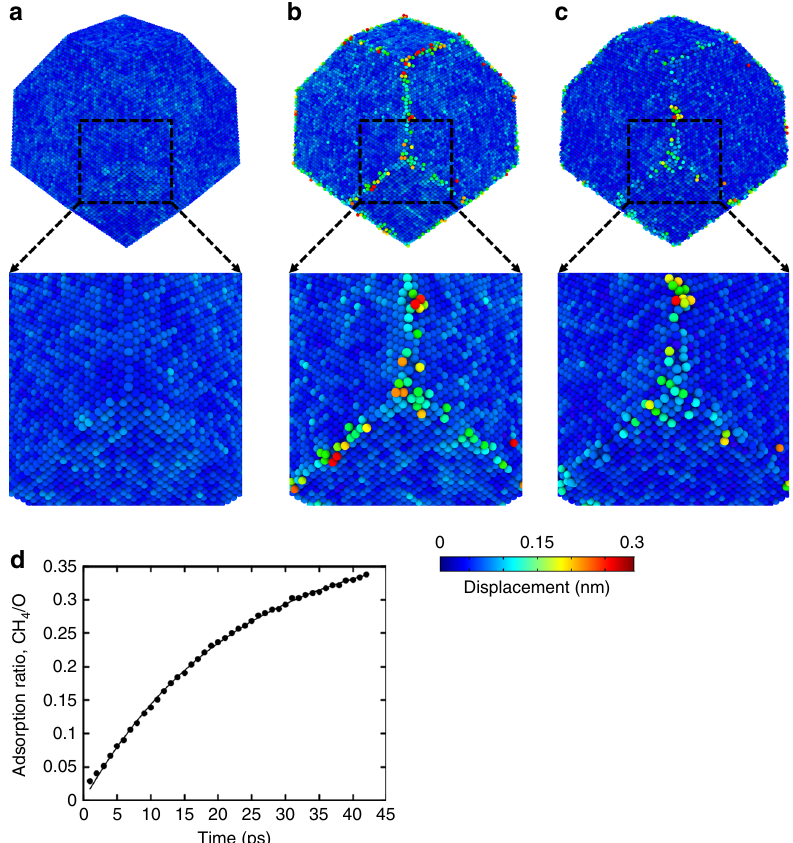
Fig. 3 Reactive molecular dynamics (RMD) simulation of Pt catalytic activity. Images of a Pt nanocrystal colored by displacement from RMD simulation results and expanded views of the region marked out in the upper image. a Pt in an environment of pure H 2 . b Pt in an environment of pure O 2 . Sur fi cial Pt atoms are displaced from their original position by oxidation of the edge and corner sites; those on faces of the particle show only weak displacements. c Oxidized Pt nanocrystals in the presence of CH 4 . d Analysis of the RMD of the ratio of adsorbed methane molecules to adsorbed oxygen atoms on the Pt nanocrystal. Only a fraction of the absorbed oxygen atoms are active for fi nal product formation owing to steric hindrance. The solid line is a fi t to A × [1 − exp( − t / B )] with t in ps, A and B are fi tting constants. Extrapolating to in fi nite time yields an adsorption ratio of 0.398 ± 0.003 at any given